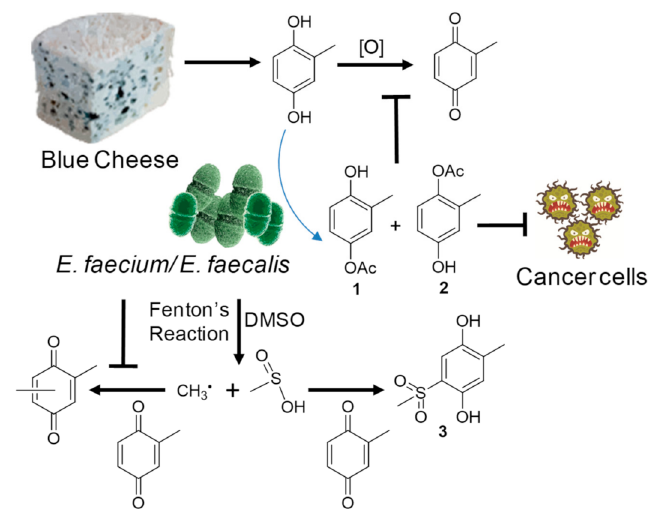
Figure 8. Effects of E. faecalis and E. faecium on transforming versatile toluquinol from Penicil- lum